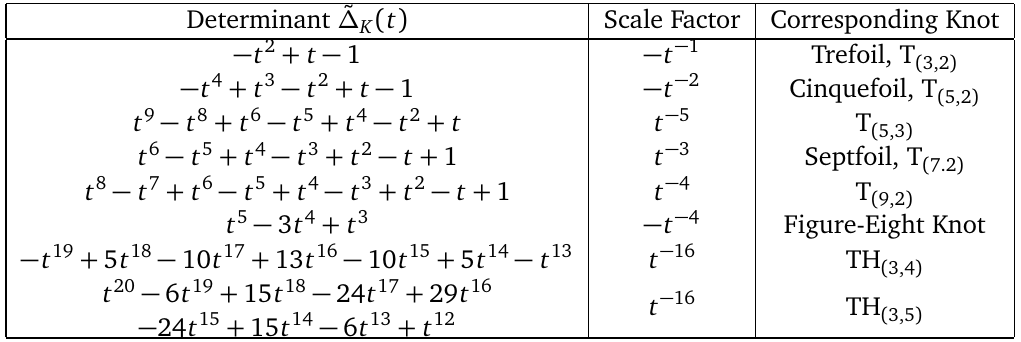
Table 1: Alexander polynomials for a few different nodal structures. The left column is what comes out from the algorithm, while the middle column is the factor which is to multiply the determinant in order to obtain the correctly scaled Alexander polyno- mial. Using these polynomials, we can determine what kind of nodal knot we have, without using graphical tools. Scale Factor